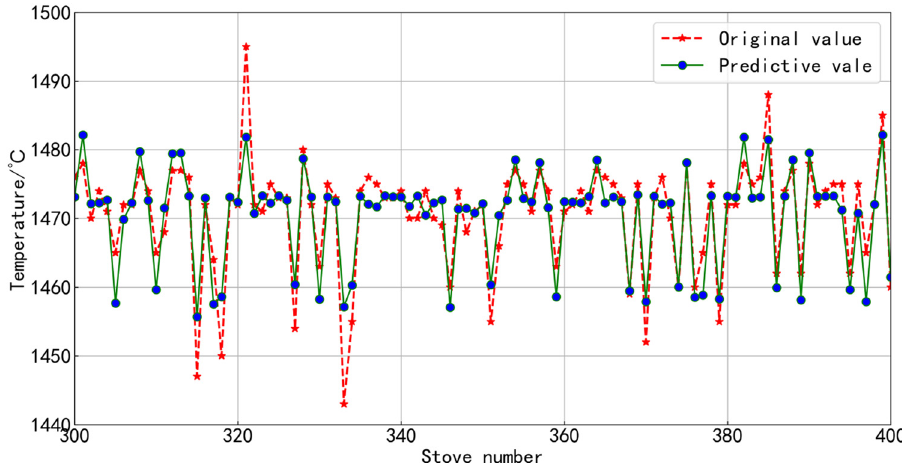
Figure 7: AdaBoost prediction result graph based on K - means